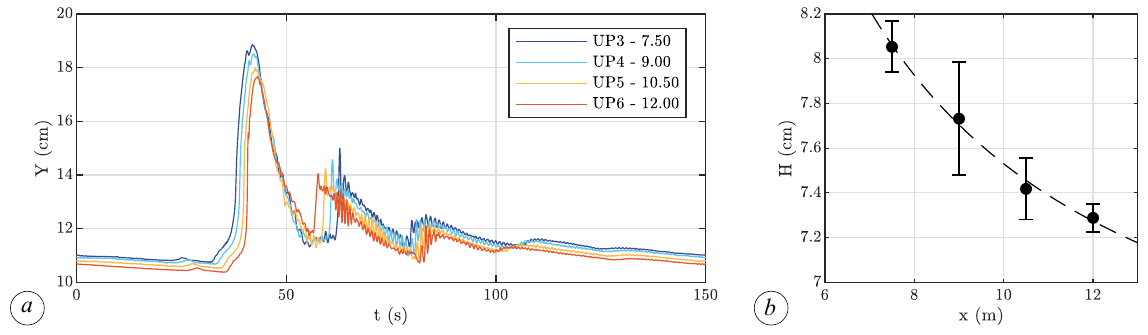
Figure 4. ( a ) Water level Y measured in 4 sections, without vegetation; ( b ) reduction of the wave height H without vegetation.